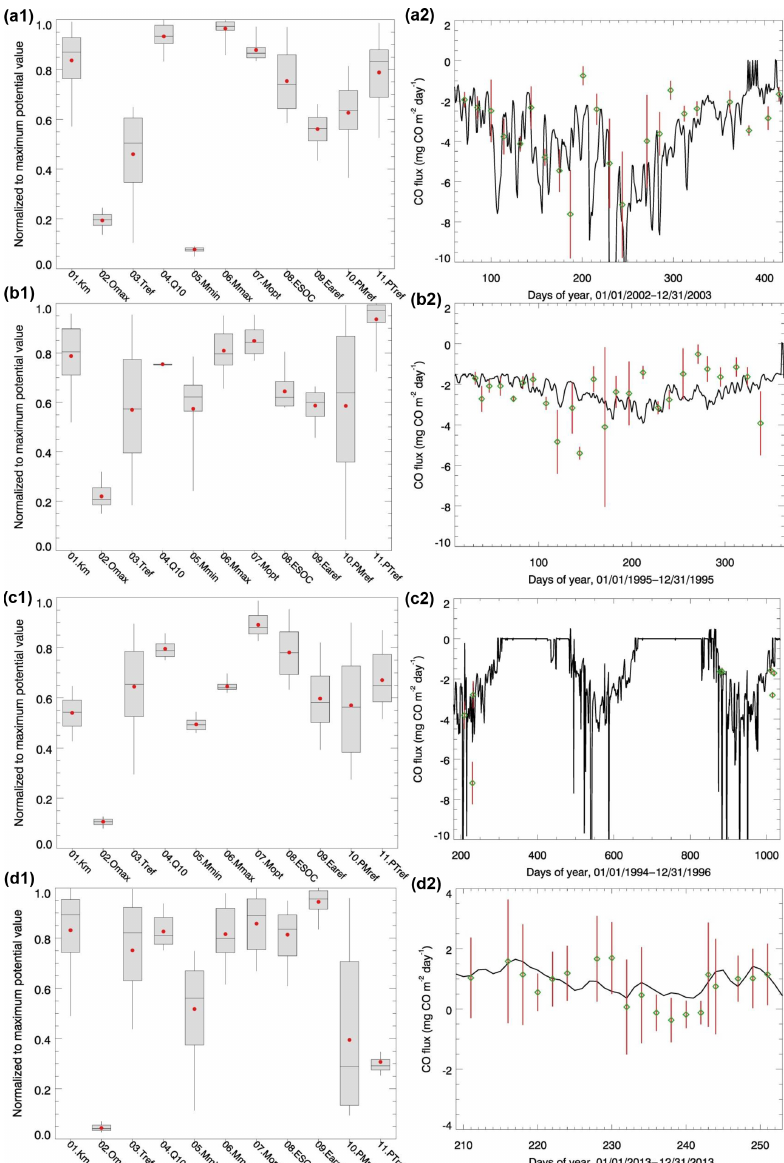
Figure 3. Parameter ensemble experiment results: each parameter has 50 calibrated values generated from running SCE-UA-R 50 times independently. Parameters are normalized to their largest potential values described in Table 2. (a1) and (a2) are temperate coniferous forest normalized parameter distribution boxplots and CO flux comparisons between the model simulations (solid line, using the mean value of parameters) and observations (green diamond; red lines represent the error bar, site no. 8), respectively. For each box, line top, box top, horizontal line inside box, box bottom and line bottom represent maximum, third quartile, median, first quartile and minimum of 50 parameter values. Red dot represents the mean value of 50 parameter values. (b1) and (b2) are plots for temperate deciduous forest (site no. 11). (c1) and (c2) are boreal forest normalized parameter distribution boxplots and CO flux comparisons between the model simulations (solid line, using the mean value of parameters) and observations (green diamond; red lines represent the error bar, site no. 12), respectively. (d1) and (d2) are for grassland (site no. 6). Grassland observation data are the sum of hourly observations, so the error bar represents the standard